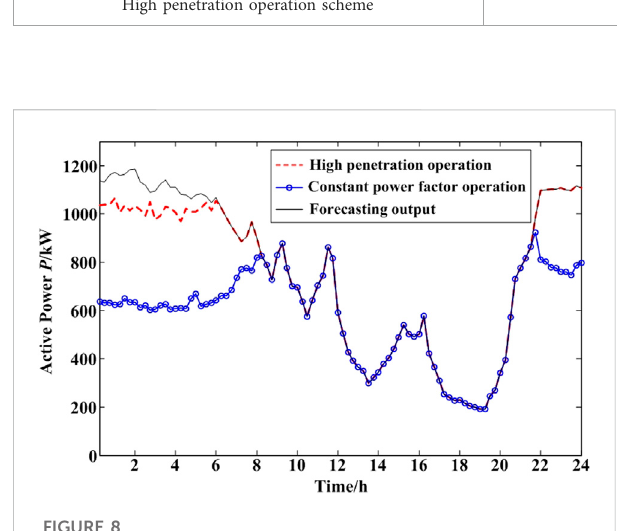
FIGURE 8 Comparison on active power of WT2 between two operation